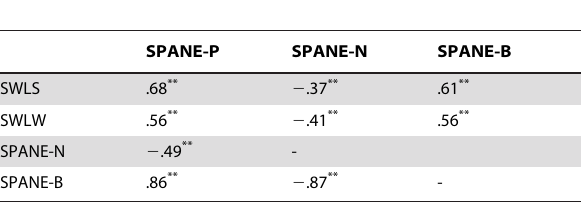
Table 8. Correlations between the SPANE and well-being